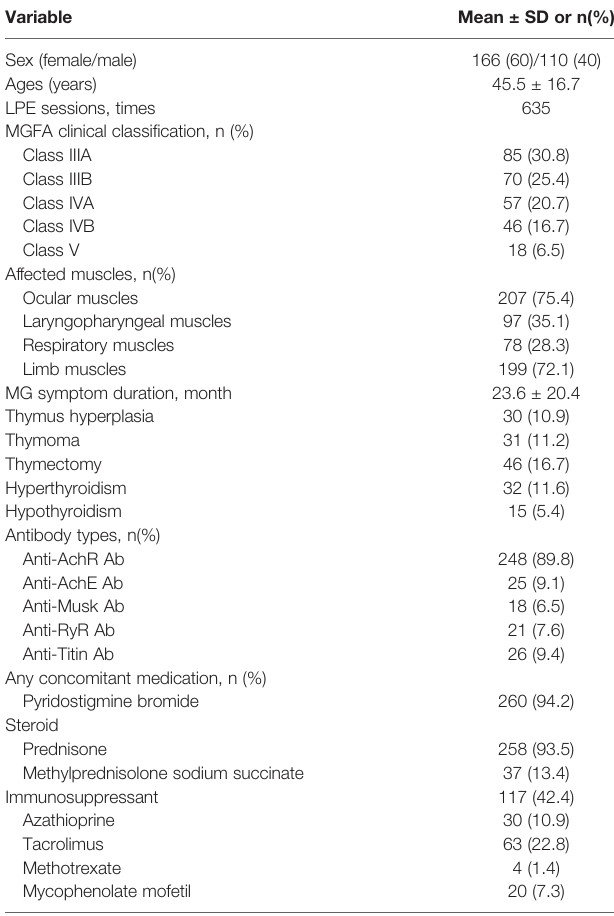
TABLE 1 | Demographic baseline characteristics of patients with myasthenia gravis.